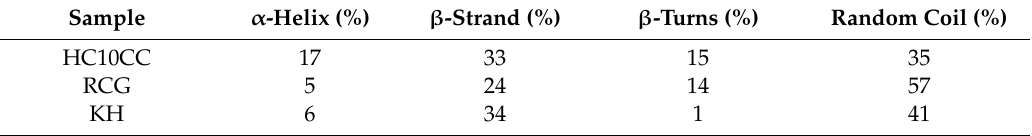
Table 4. The structure of extracted proteins measured by circular dichroism (CD).